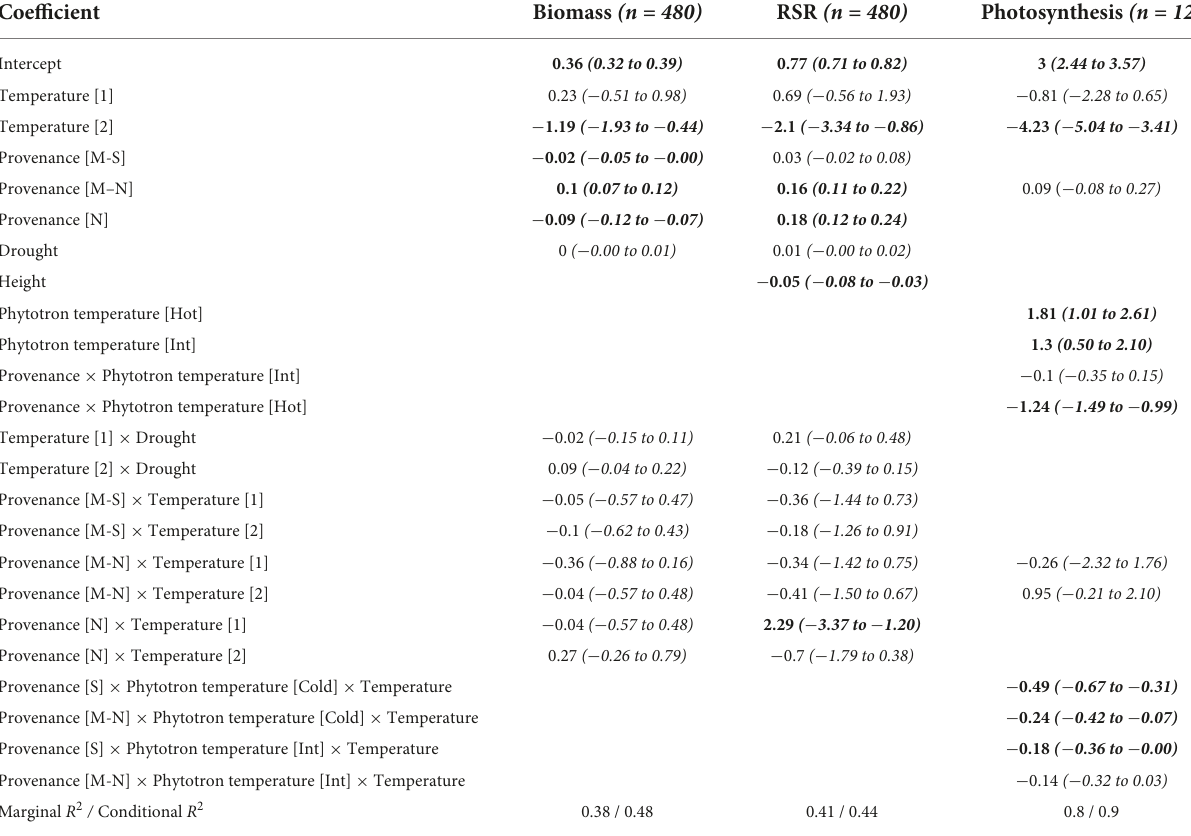
TABLE 2 General linear mixed-effects model coefficients for the biomass, root:shoot ratio (RSR), and photosynthesis models.